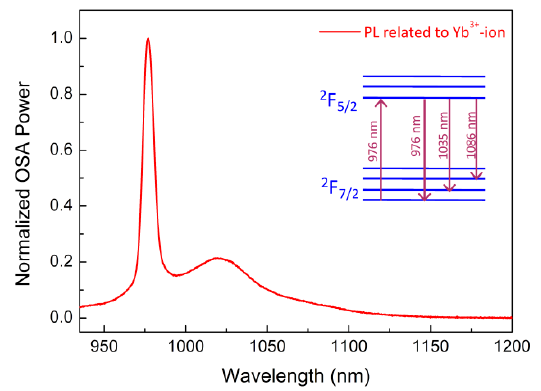
Figure 6. OSA measurement of theYb 3+ -emission in the NIR region. The scheme of the sublevel Yb 3+ transitions between the ground and the excited state is also shown. transitions between the ground and the excited state is also shown.